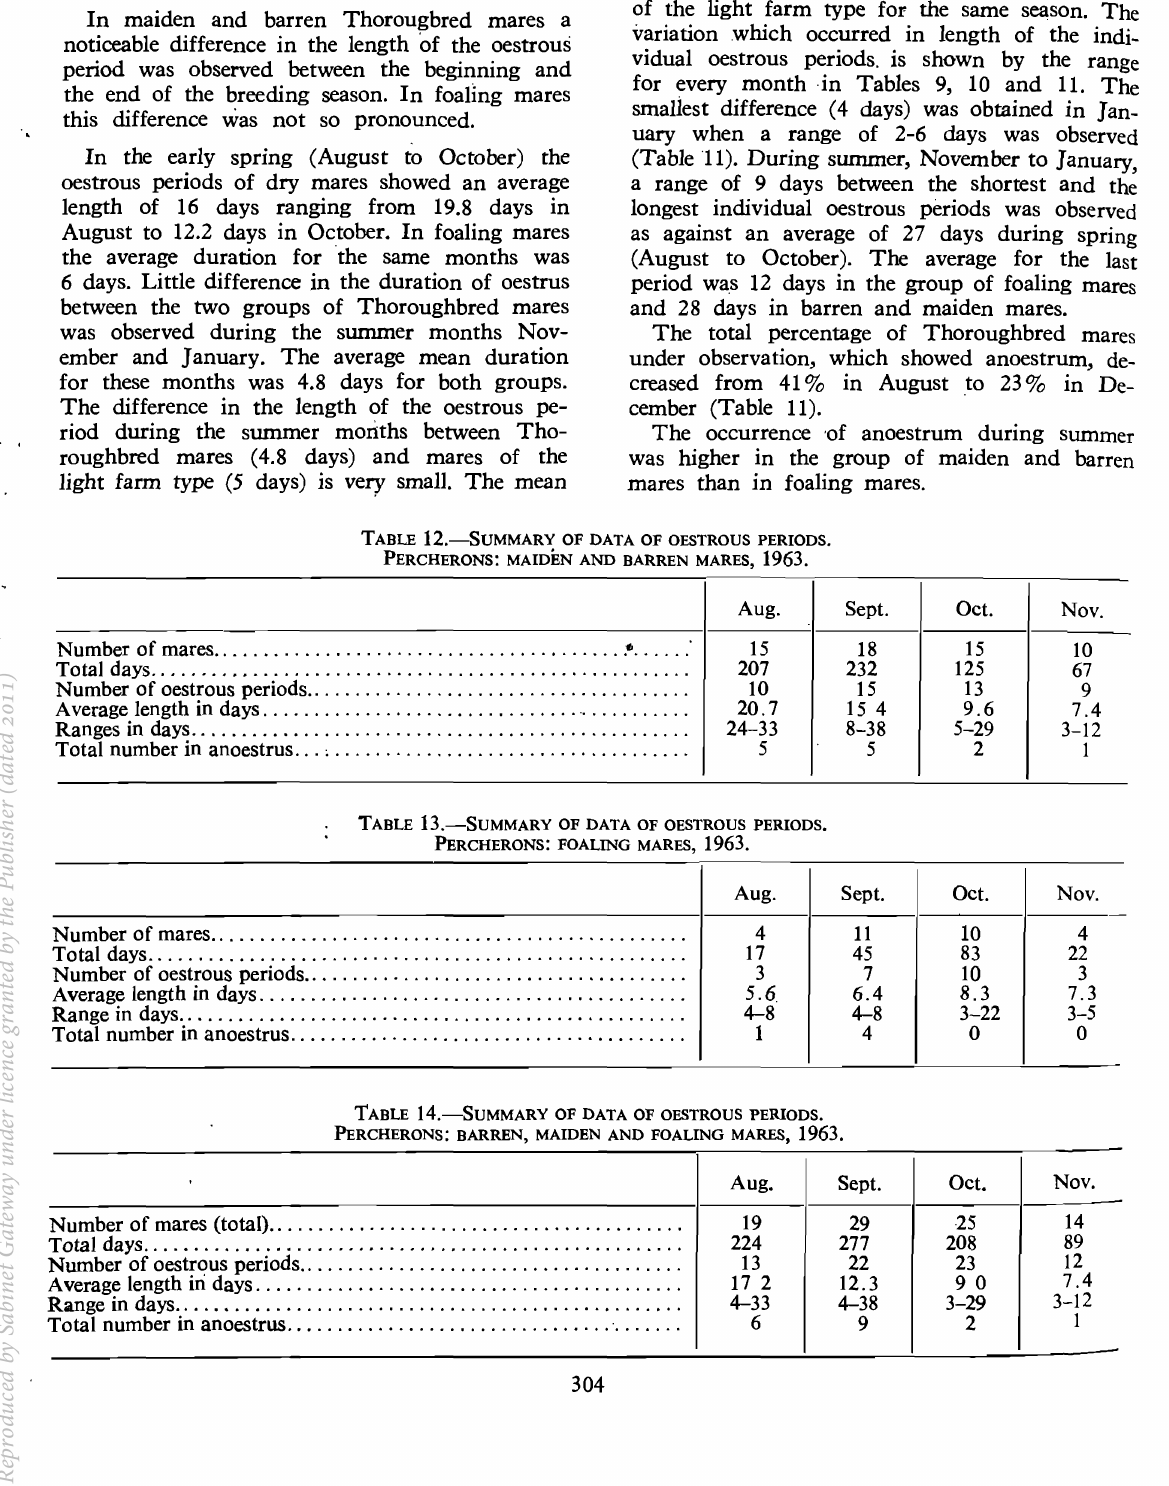
TABLE 12.-SUMMARY OF DATA OF OESTROUS PERIODS. PERCHERONS: MAIDEN AND BARREN MARES, 1963.